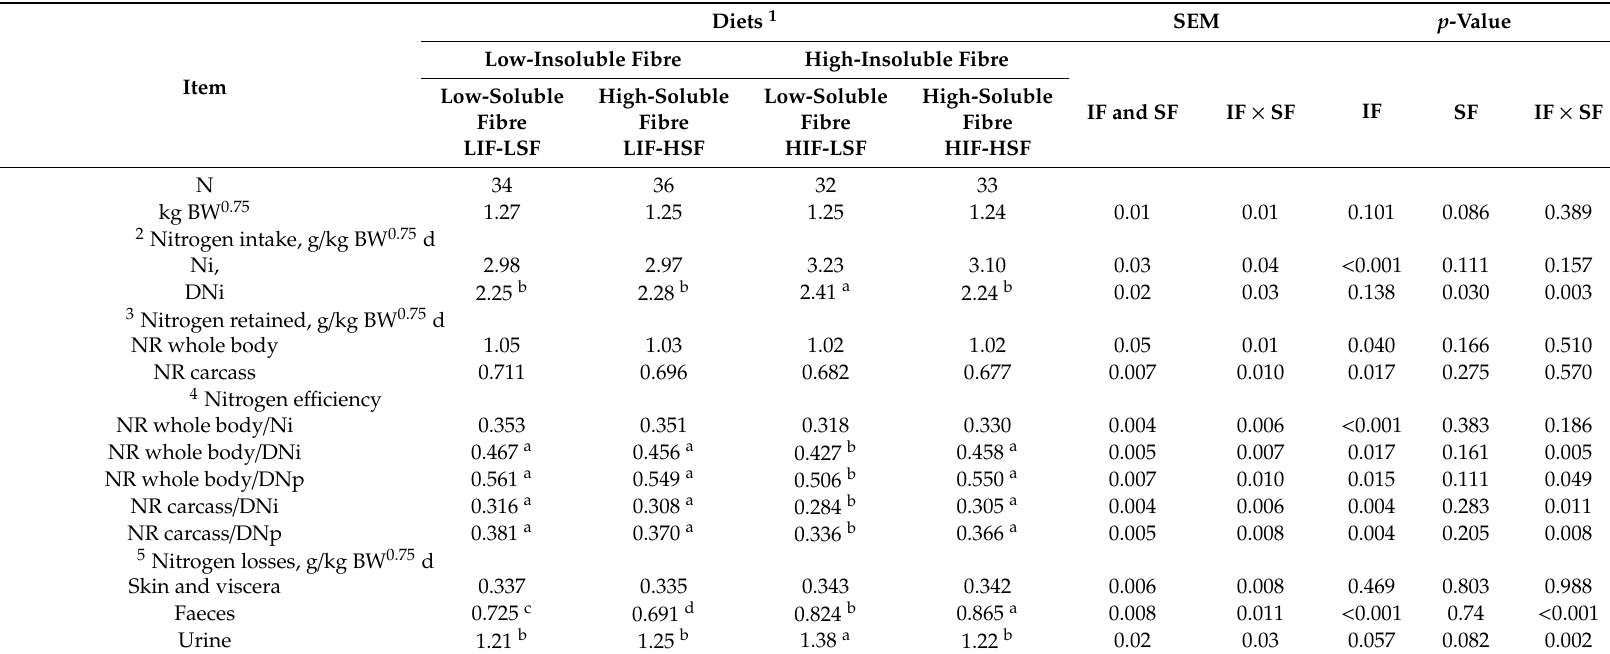
Table 4. E ff ect of dietary level of insoluble and soluble fibre on nitrogen (N) balance from 28 to 62 days of